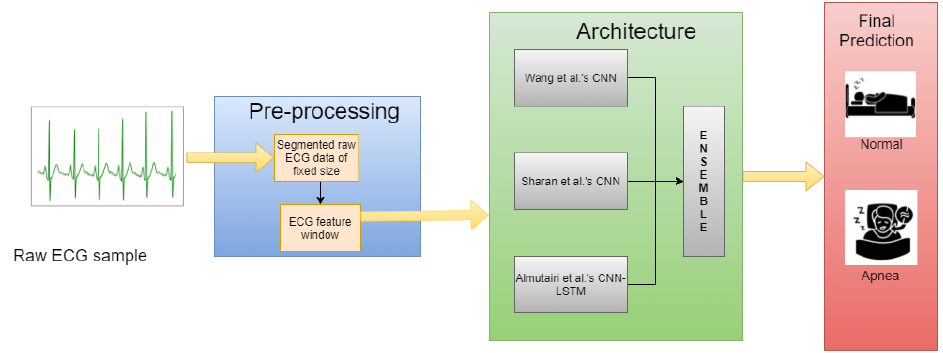
Figure 1. Overall workflow of the ensemble based OSA detection